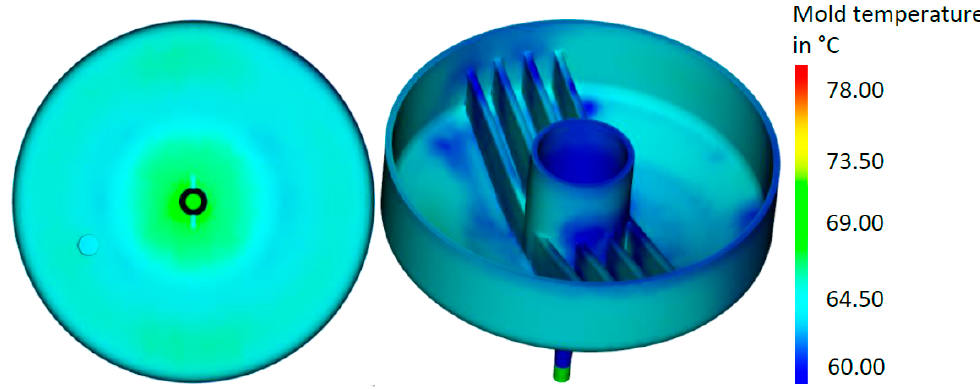
Figure 15. Temperature distribution on the surfaces of the mold part for optimized close-contour cooling.